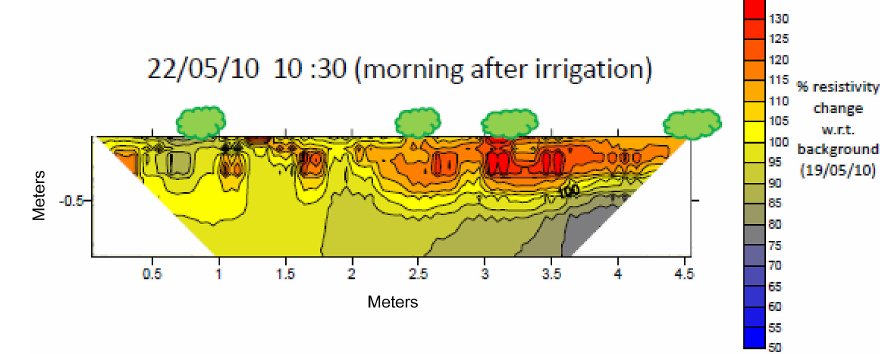
Fig. 8. Plant distribution along ERT line NA (fallow plot).